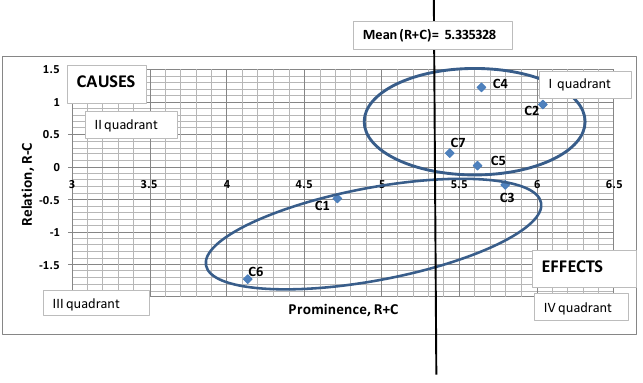
Figure 5. Results of DEMATEL application — group context.